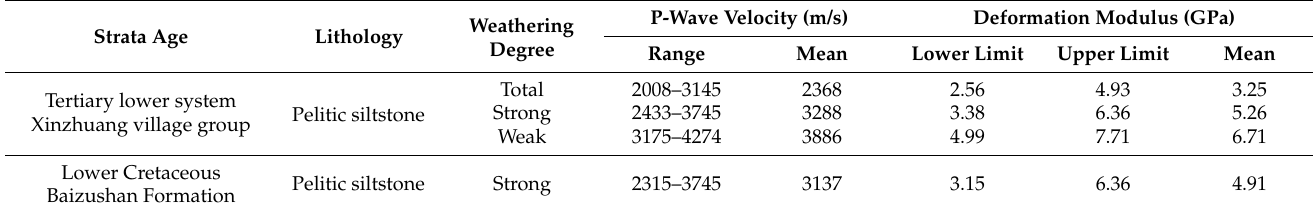
Table 2. Estimation of deformation modulus of pelitic siltstone in different strata.